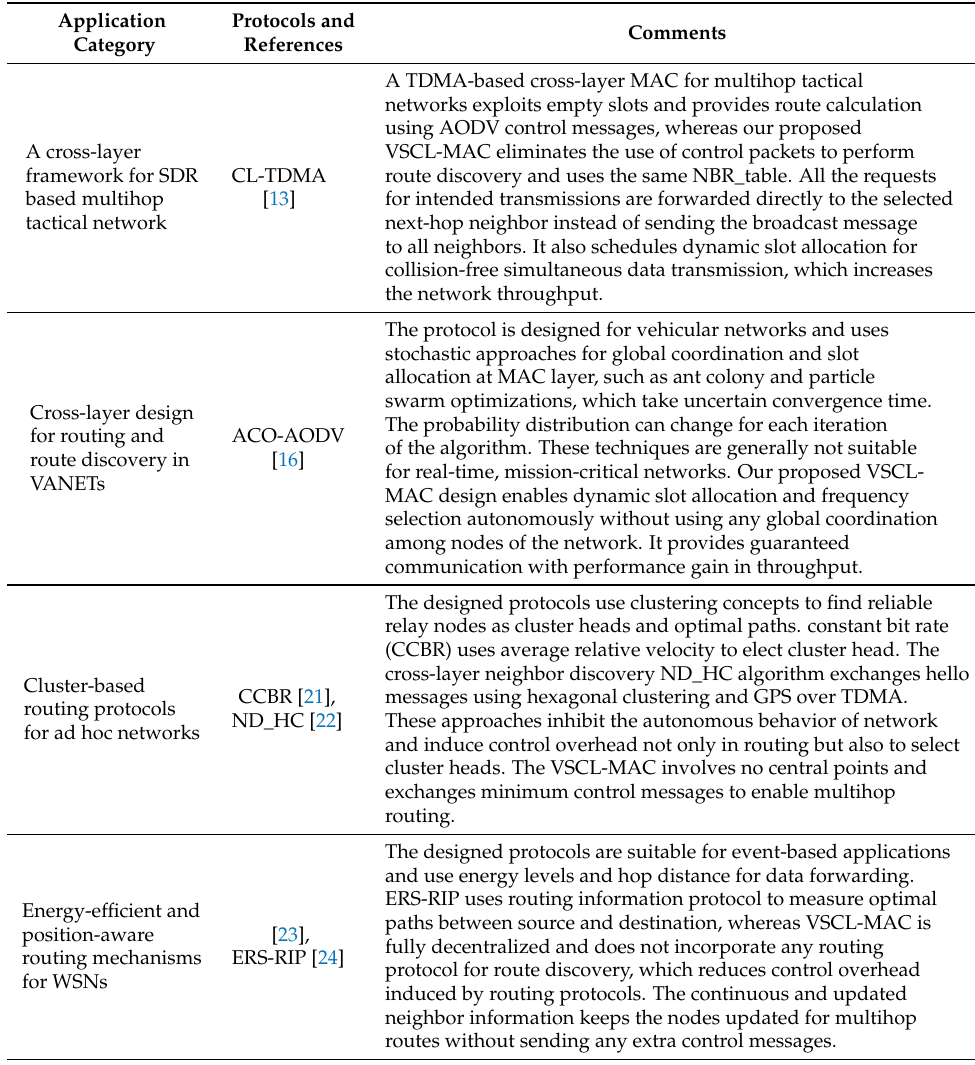
Table 12. Qualitative comparison of VSCL-MAC protocol with other cross-layer protocols. Application